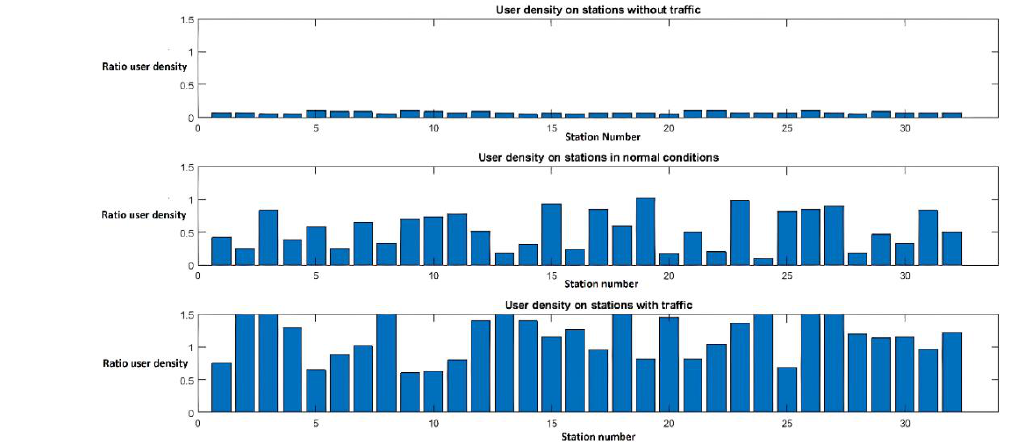
Figure 12. Density of users in a station: ( a ) without traffic conditions, ( b ) normal traffic conditions, and ( c ) with traffic conditions. See Table 3.